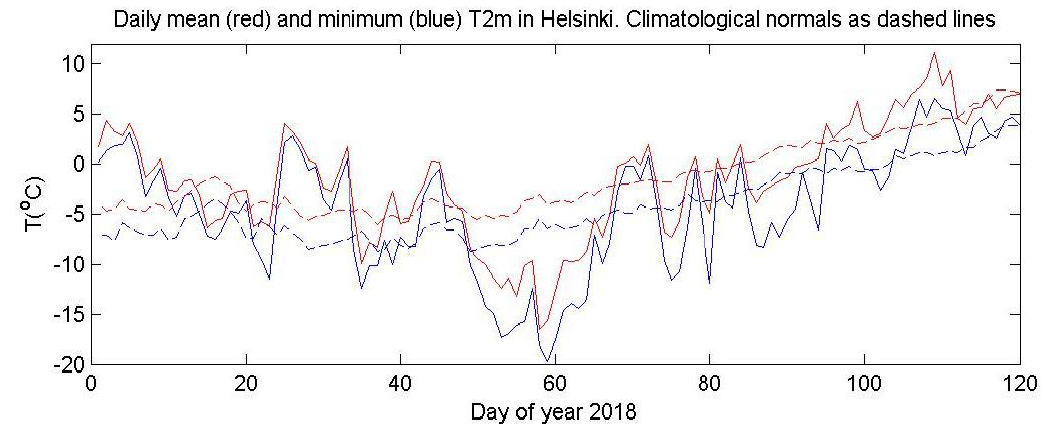
Figure 6. Helsinki daily mean and minimum temperature for early 2018 relative to the climatology averaged over 1981–2010. Data from Finnish Meteorological Institute.